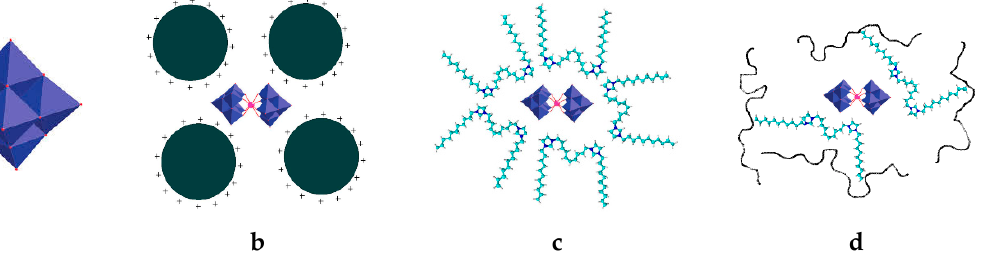
Figure 8. Schematic representation of different environment for Eu-POM: ( a ) water; ( b ) PMMA latex; ( c ) aqueous BIBr solution; ( d ) PAM hydrogel.